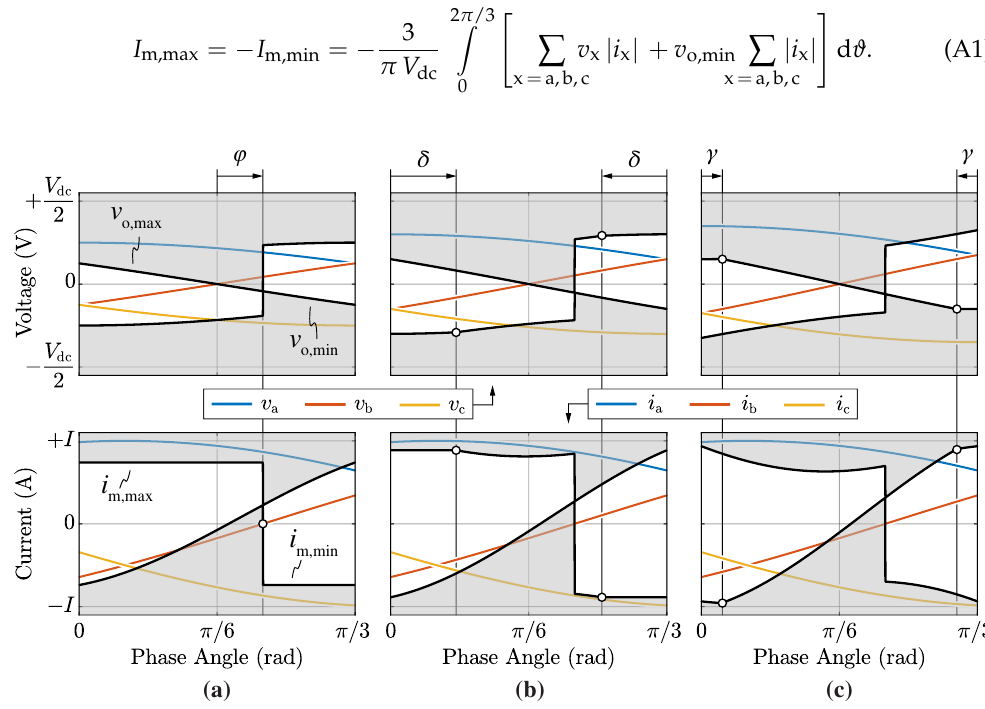
Figure A1. Zero-sequence voltage limits v o,max , v o,min and mid-point current local average limits i m,max , i m,min for ( a ) M = 0.5 (region 1 ), ( b ) M = 0.6 (region 2 ) and ( c ) M = 0.7 (region 3 ) assuming ϕ = 10°. The focus is on 0 ≤ ϑ ≤ π / 3 to highlight the most relevant angle definitions for the analytical calculations (i.e., ϕ , δ , γ